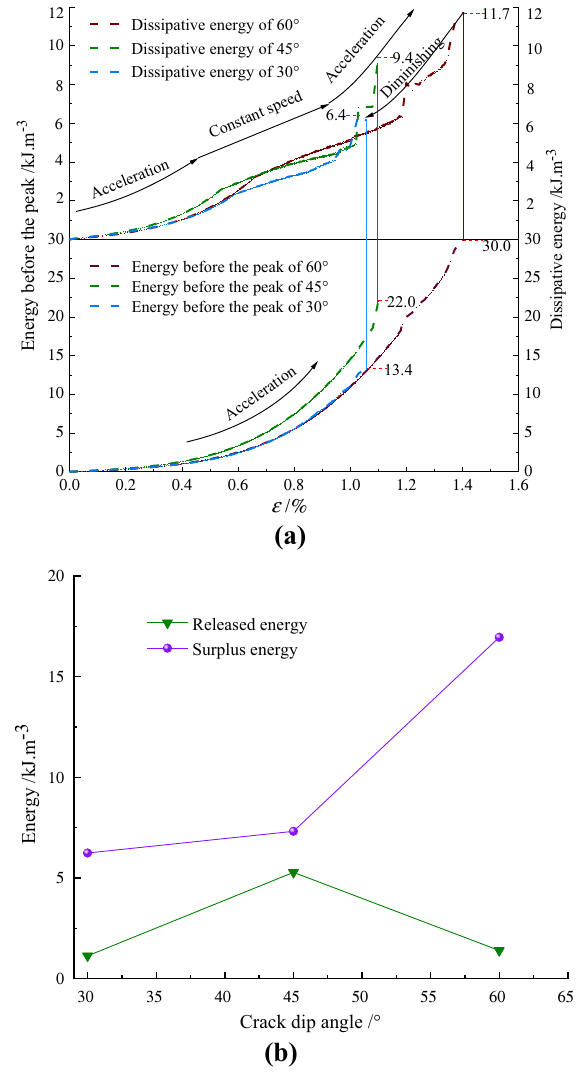
Fig. 7 Energy-conversion rules for precracked rock samples: a before peak; b after